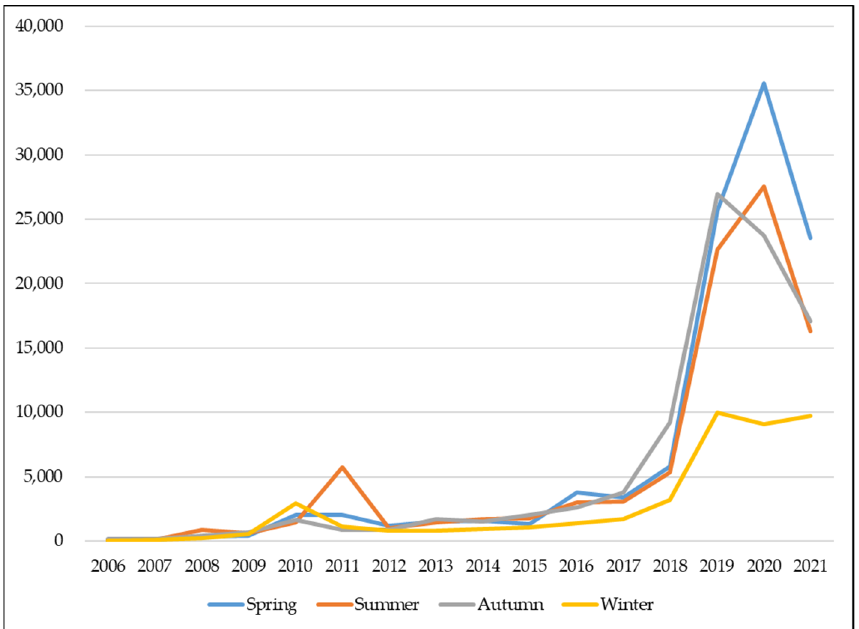
Figure 4. Comparative analysis of the changes in the number of reviews in different